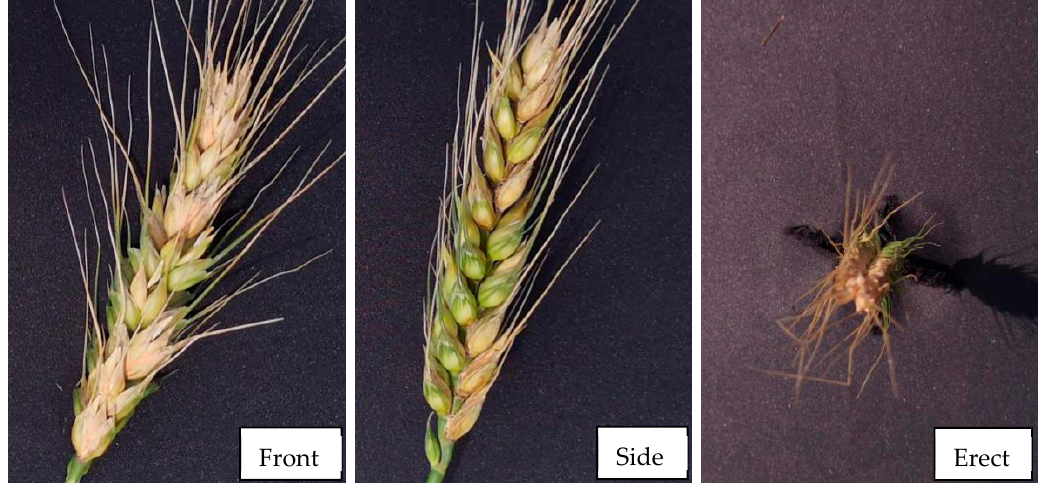
Figure 3. FHB-infected ear of winter wheat at three measuring angles (front, side, and erect).